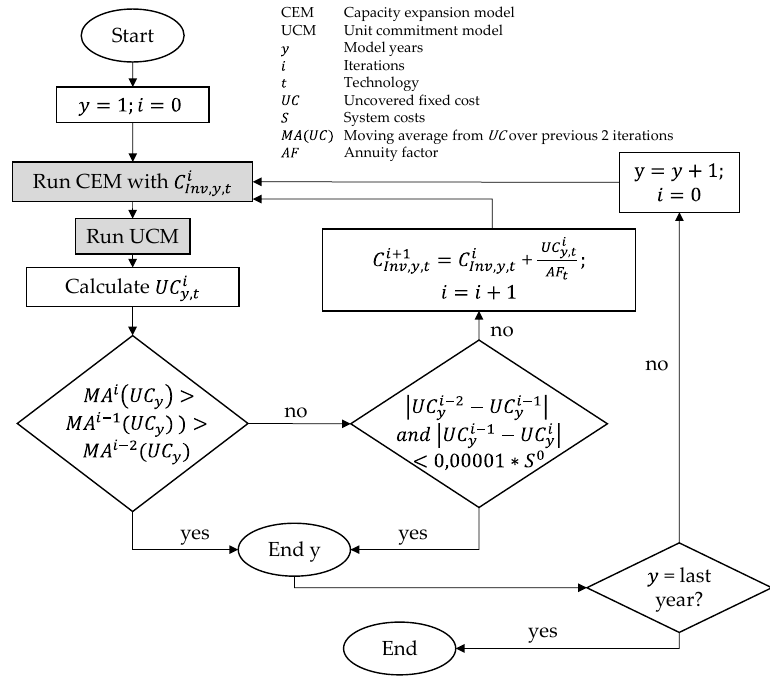
Figure 3. Iteration flowchart for myopic model runs.